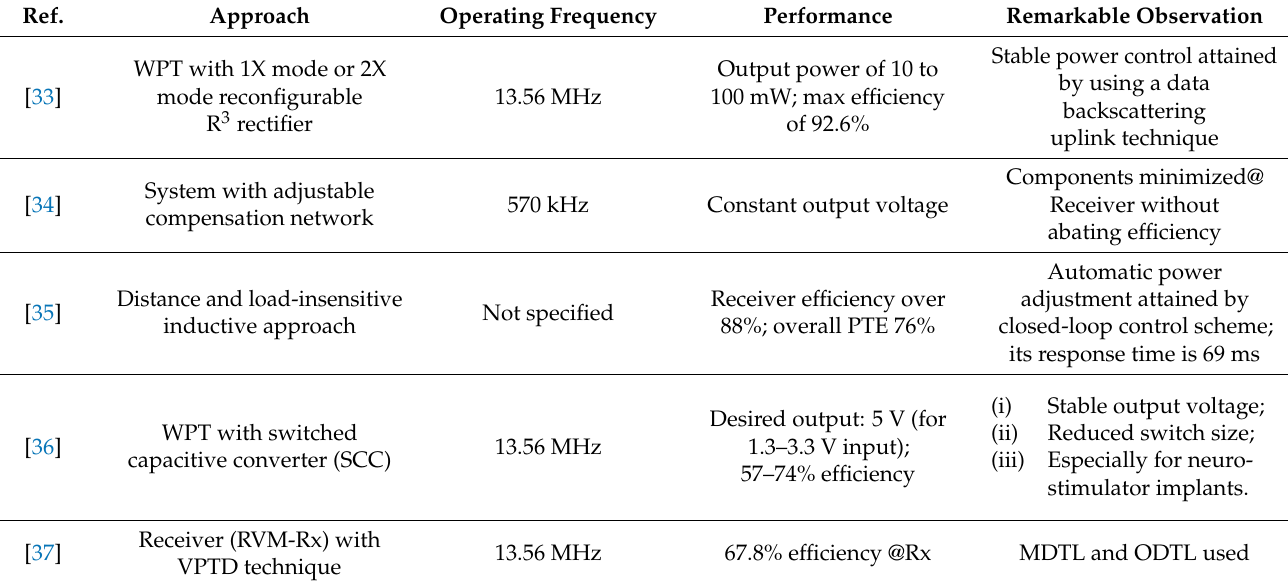
Table 3. WPT systems based on power control and regulation